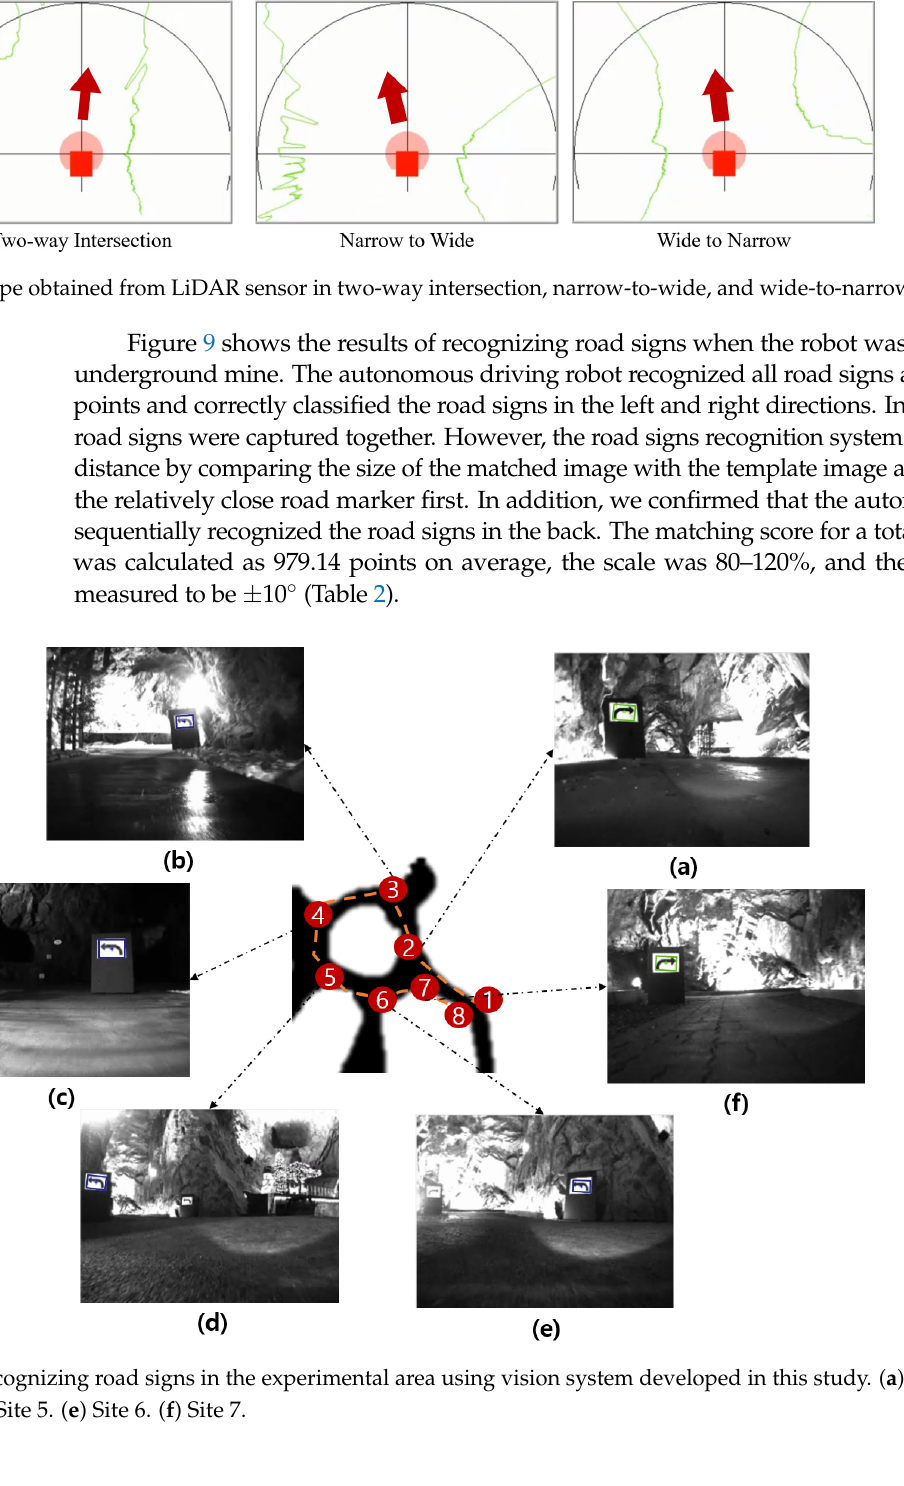
Figure 9. View of recognizing road signs in the experimental area using vision system developed in this study. ( a ) Site 2. ( b ) Site 3. ( c ) Site 4. ( d ) Site 5. ( e ) Site 6. ( f ) Site 7. Site 3. ( c ) Site 4. ( d ) Site 5. ( e ) Site 6. ( f ) Site